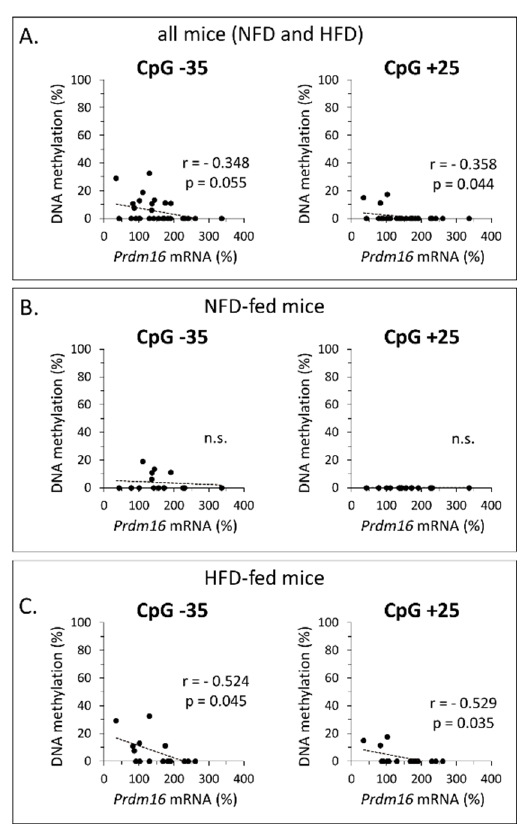
Figure 4. Pearson’s correlation analyses between Prdm16 mRNA expression levels in inguinal WAT and site-specific Prdm16 promoter methylation at CpG − 35 and +25. Analyses were performed using data from male mice neonatally treated with resveratrol or nicotinamide riboside and submitted in adulthood to a high-fat/normal-fat diet (HFD/NFD) challenge and their corresponding vehicle-treated controls. Correlations are shown for: all animals in the study ( A ), the NFD-fed animals only ( B ), and the HFD-fed animals only ( C ). For each analysis, r and p values are indicated. No significant correlations between methylation degree and gene expression levels were observed for any other CpG in the Prdm16 promoter